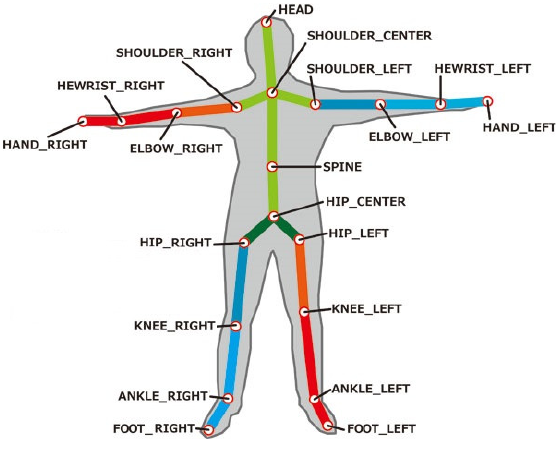
Figure 1. Body joint positions.